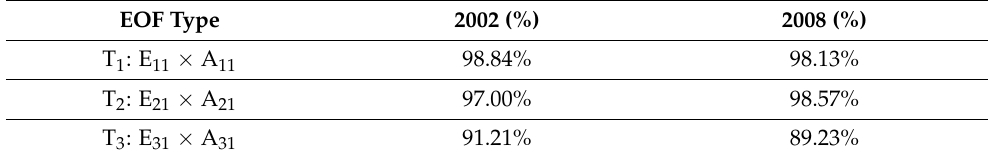
Table 2. Variance contribution of the first mode obtained by EOF decomposition of the first three time coefficients T i (t) (i = 1, 2, 3) in each of 2002 and